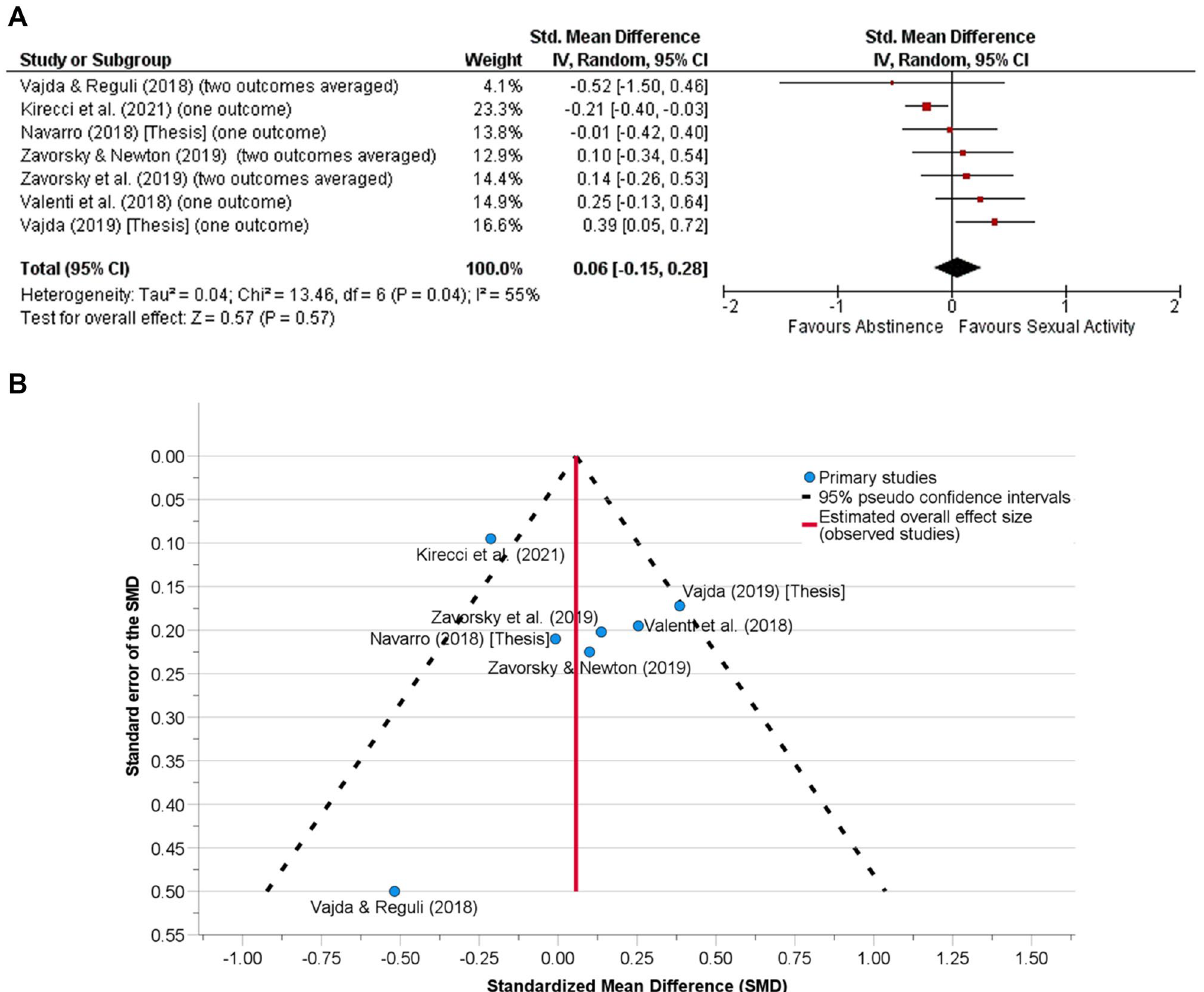
Figure 3. (A) The effect of sexual activity that occurred 30 min to 24 h before assessing muscular strength or power is displayed using a Forest Plot. There were two outcomes each for Zavorsky and Newton 44 (n = 10), Zavorsky et al . 45 (n = 7), and Vajda and Rejuli 51 (n = 2); thus, the standardized mean difference (SMD) and standard error of the SMD was averaged for each of these studies. The data demonstrate that muscular strength or power is unlikely affected by prior sexual activity or abstinence ( p = 0.57). That is, both experimental and control conditions provide similar test results. A random-effects model was used. No other adjustments were made here. There was substantial heterogeneity between studies ( p = 0.04). ( B ) Funnel plot for the detection of publication bias in ( A ). Egger’s random effects meta-regression-based test was used with the Knapp-Hartung SE adjustment. There was no funnel plot asymmetry (Intercept = 0.05, SE = 0.27, t = 0.20, p = 0.85, 95% CI of the coefficient = − 0.65 to 0.75); Standard error of the effect size = 0.02, SE = 1.38, t = 0.02, p = 0.99, 95% CI − 3.53 to 3.58). After adjusting for the missing studies, the SMD (SE of the SMD) was the same as ( A ), demonstrating that muscular strength or power is unlikely affected by prior sexual